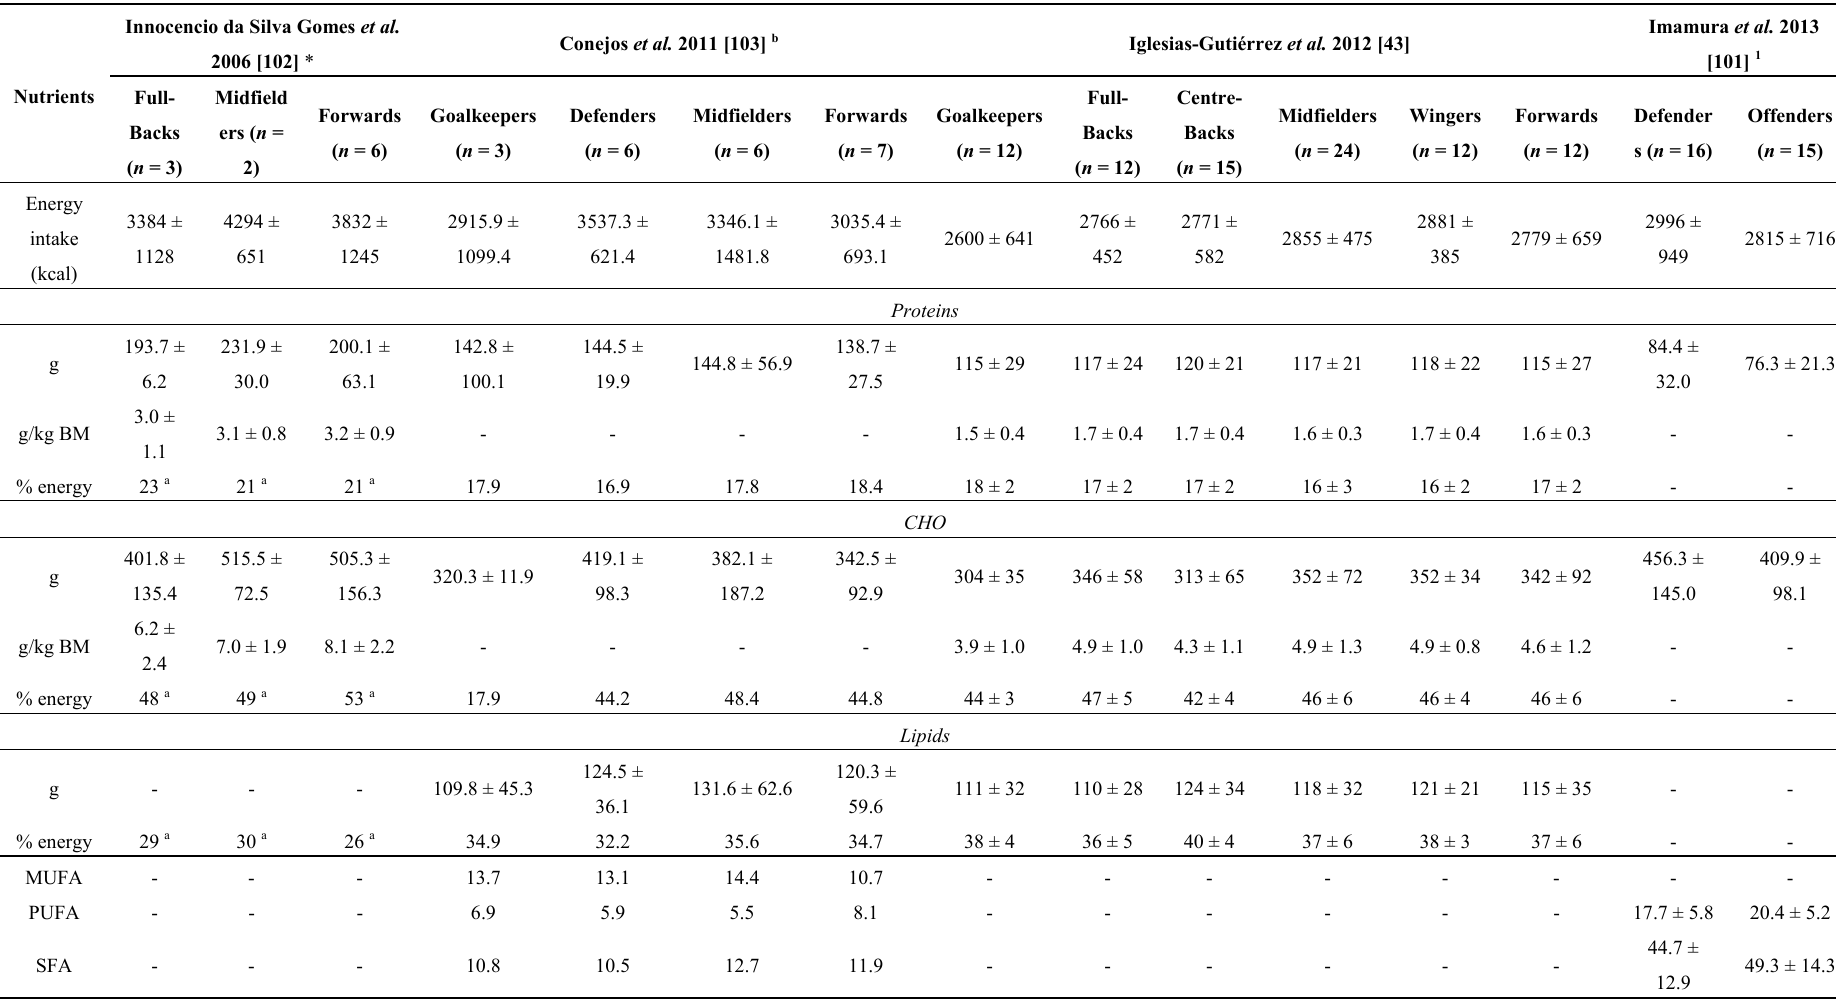
Table 4. Studies examining the energy and macronutrient intake of soccer players according to their playing position on the field. Innocencio da Silva Gomes et al. Nutrients